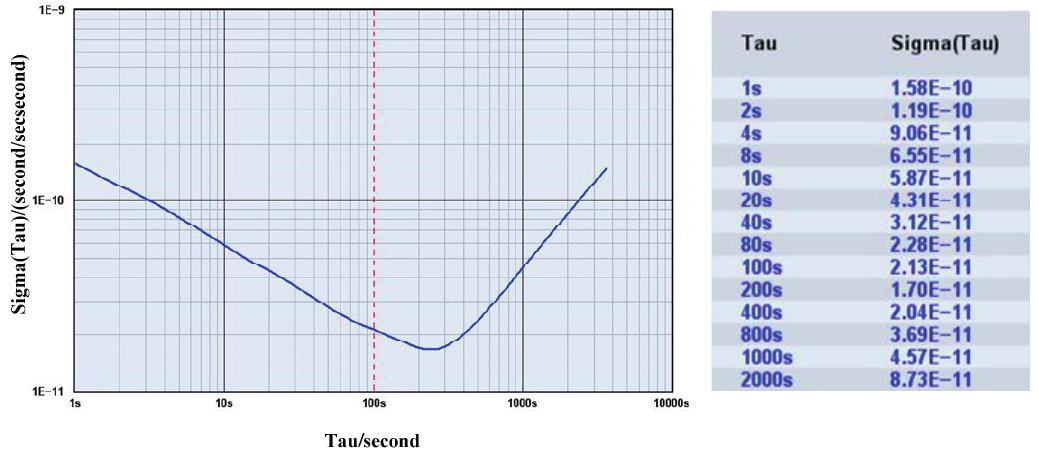
Figure 19. Allan root deviation of CSAC measured by Symmetricom 3120A.